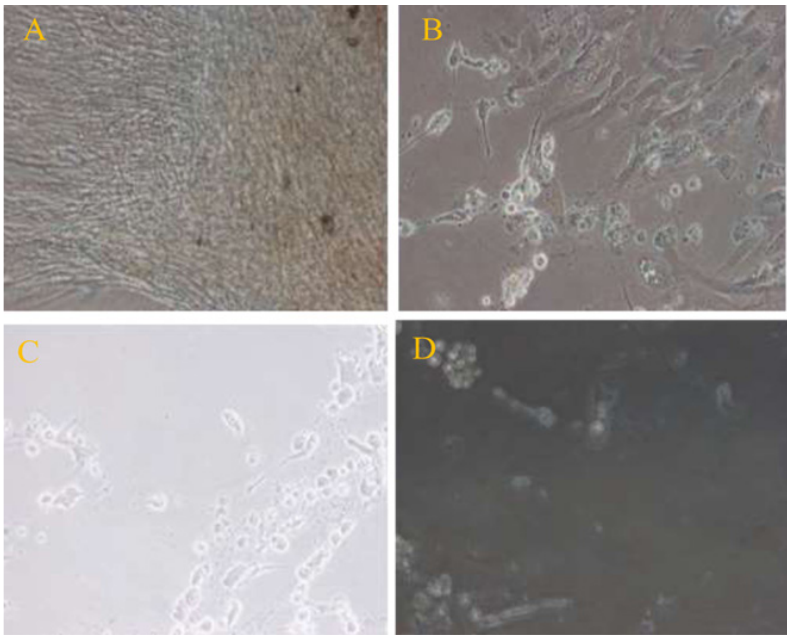
Figure 2. Morphological changes of hUMSCs following treatment. Untreated hUMSCs (A). The morphological changes began after 24 h including narrowing on one side of the cells (B). The morphological changes after 48 h are very severe (C). Severe morphological changes including rounding, elongation and narrowing on one side of the cytoplasm were seen in most of the cells, after 72 h (D).